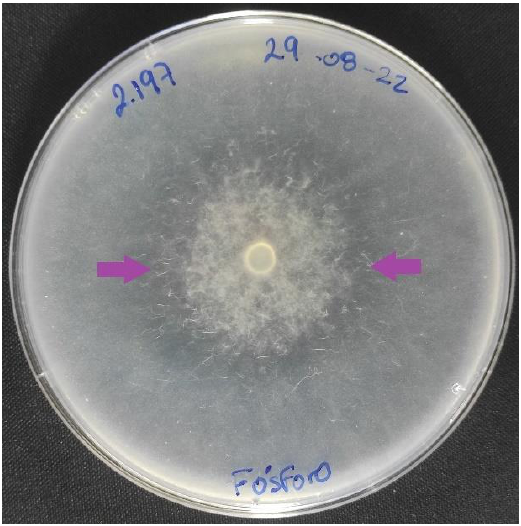
Figure 2. Nematode-capturing fungus Arthrobotrys oligospora . Phosphate solubilization zone on Pikovskaya agar plates, as shown by the halo (arrows). Pikovskaya agar plates, as shown by the halo